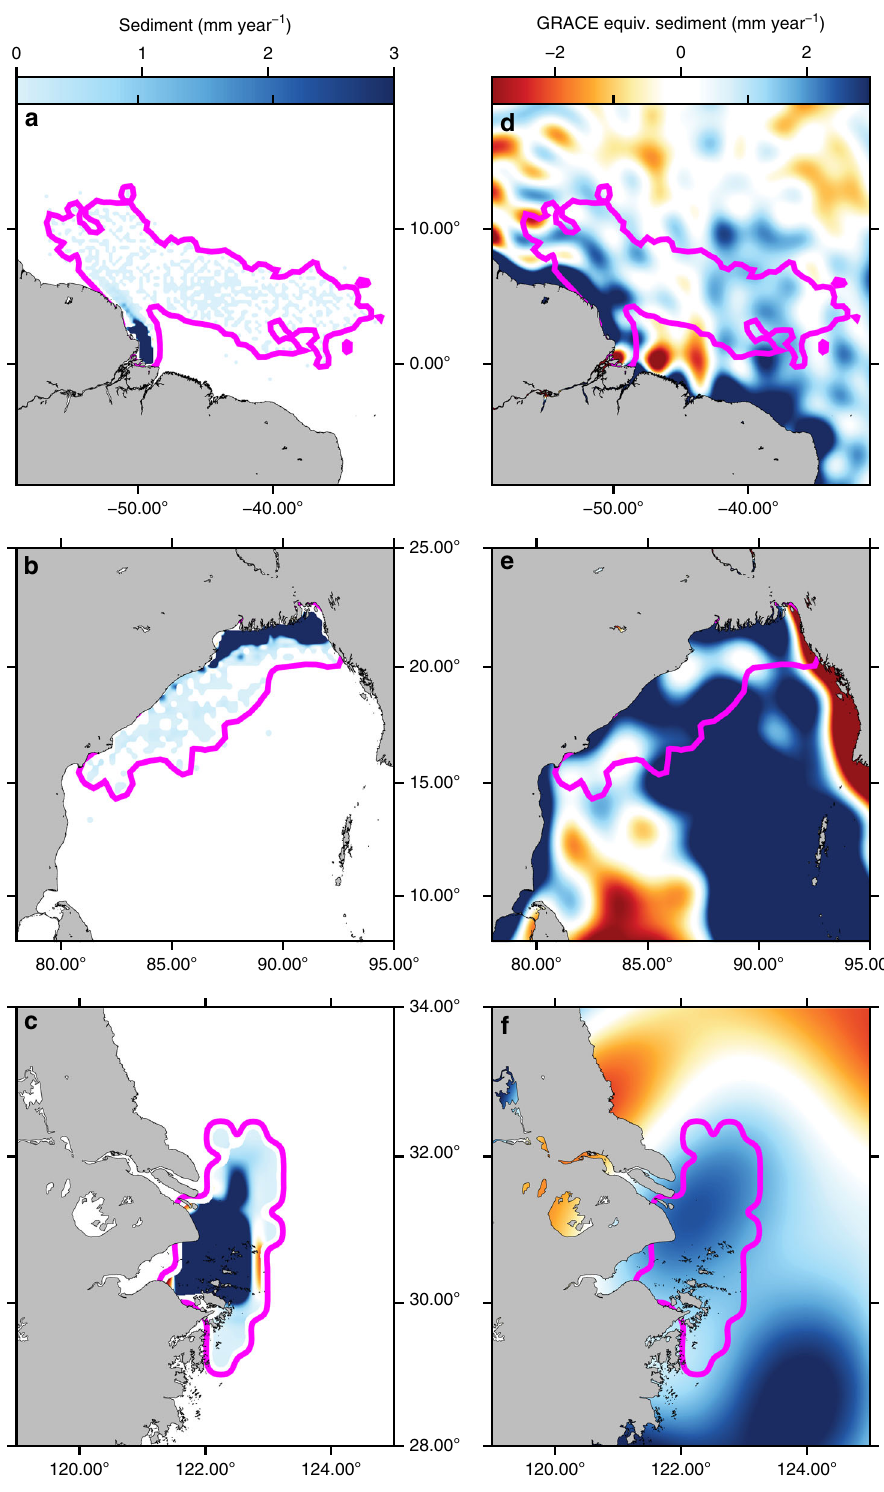
Fig. 2 Maps of annual offshore sedimentation and collocated GRACE signal. Modeled sedimentation rates out of a the Amazon, b the Ganges-Brahmaputra, and c the Changjiang (or Yangtze) for 10- µ m diameter sediment particles. The sedimentation area contour is the pink line. d – f GRACE equivalent sediment thickness (assuming that sediment replaces water) over the same areas, the sedimentation area contour is also superimposed. Mass variations over the continents are masked to improve fi gure readability (see Supplementary Fig. 4 for unmasked GRACE signal over the continents). Figure 2 created using GMT software